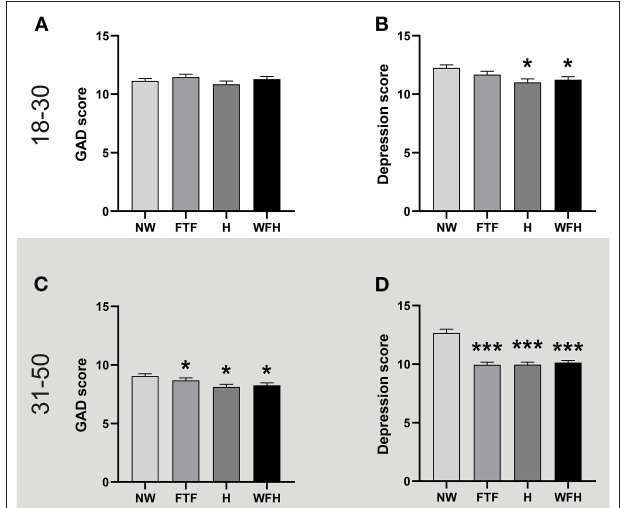
FIGURE 6 | Working was associated with less depression during the second wave. The figures show the mean + SEM of GAD or Depression scores of non-working people (NW), and those who work face to face workers, hybrid modality (H), or from home (WFH). The descriptive statistics are reported in Supplementary Table 6 . Top panel: People aged between 18 and 30. (A) GAD scores were equivalent regardless of the working status or modality. One-way ANOVA, p > 0.05. (B) Working was associated with lower depression levels except for FTF modality. * p < 0.05, vs. NW, Kruskal-Wallis analysis after a one-way ANOVA (non-parametric); Cohen’s f 2 = 0.17 and 0.16, and vs. NW for H and WFH respectively; η 2 = 0.0065. NW ( n = 568), FTF ( n = 451), H ( n = 311), and WFH ( n = 514). Bottom panel: People aged between 31 and 50. (C) Working was associated with lower GAD scores regardless of the modality. * p < 0.05 vs. NW, Kruskal-Wallis analysis after ANOVA (non-parametric); Cohen’s f 2 = 0.06; 0.15 and 0.14 vs. NW for FTF, H and WFH respectively; η 2 = 0.0064. (D) Working was associated with lower depression levels regardless of the modality. *** p < 0.001 vs. NW, Kruskal-Wallis analysis after ANOVA (non-parametric); Cohen’s f 2 = 0.32, 0.33 and 0.33 vs. NW for FTF, H and WFH respectively; η 2 = 0.023. NW ( n = 346), FTF ( n = 630), H ( n = 643), and WFH ( n =